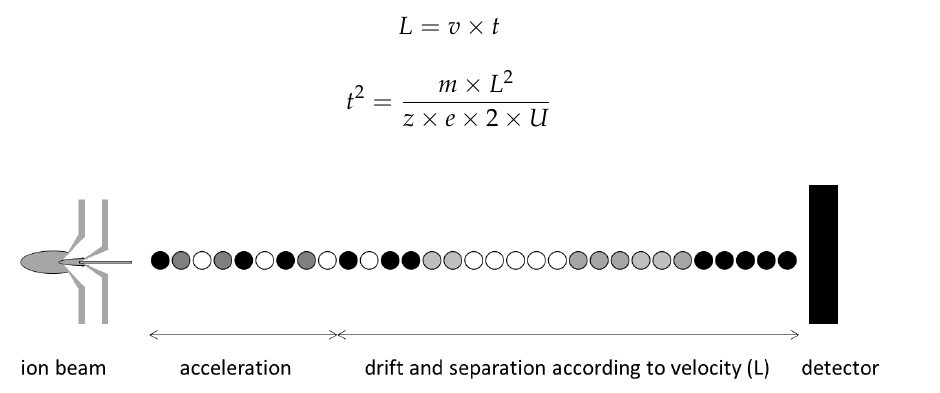
Figure 9. Time of flight measurement (adapted from [70]).